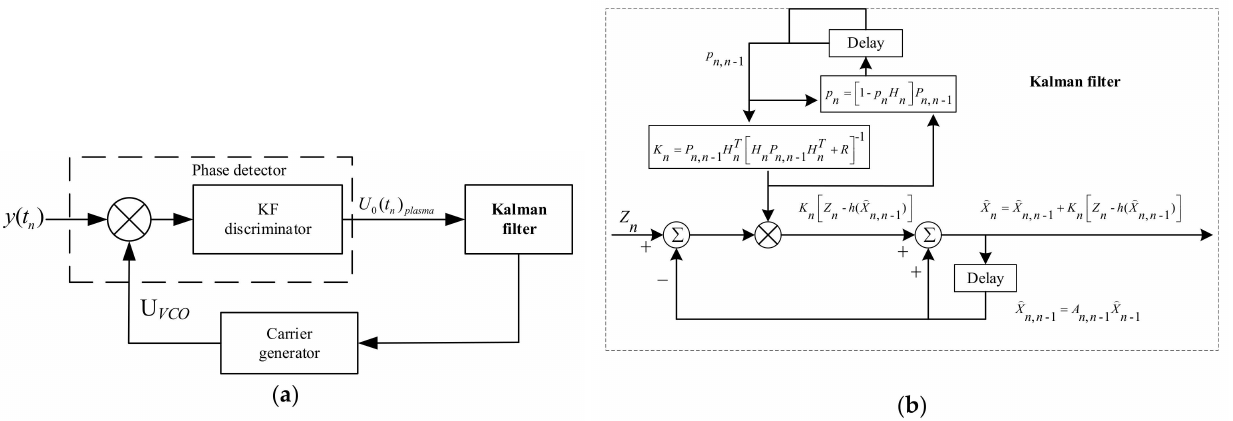
Figure 4. Unconventionally designed Kalman-filter-based carrier tracking loop. ( a ) Overall architecture and ( b ) Kalman filter